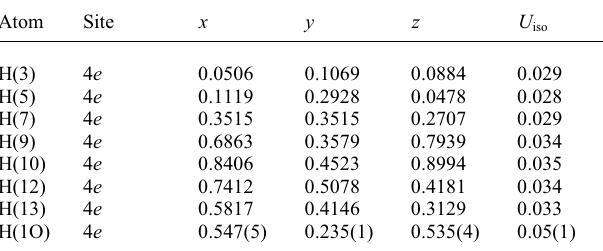
Table 2. Atomic coordinates and displacement parameters (in Å 2 )